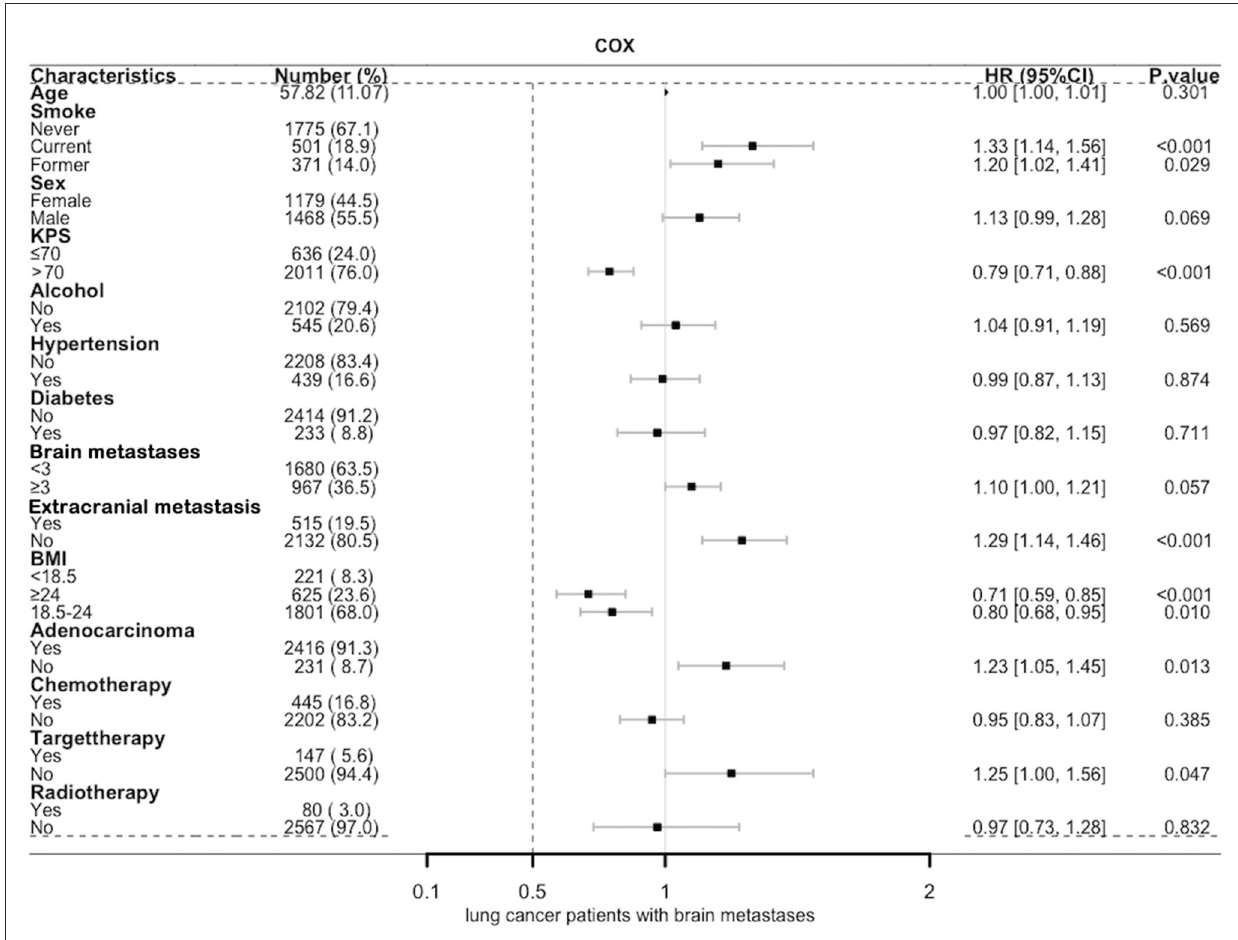
FIGURE1 Multivariate Cox forest map of lung cancer patients with brain metastases. BMI, body mass index (recorded when brain metastases was diagnosed); KPS, Karnofsky performance status; Brain metastases, number of brain metastases.